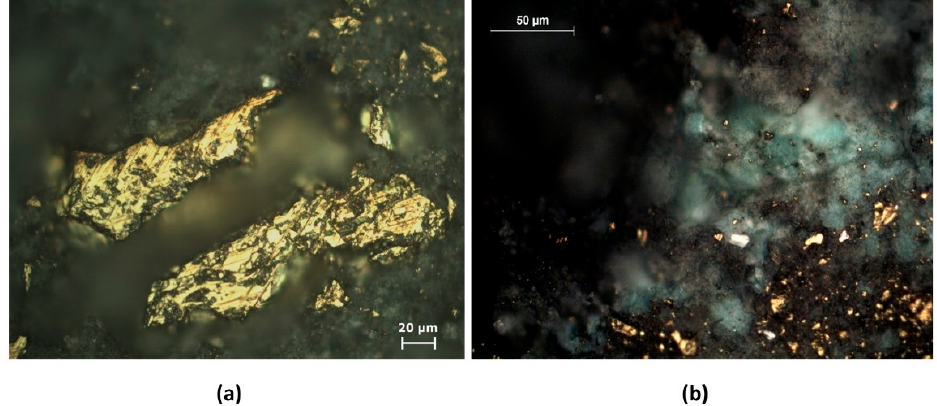
Figure 6. Reflected optical microscope images of the pretreatment products at a magnification of ×50 ( a , b ). × 50 ( a , b